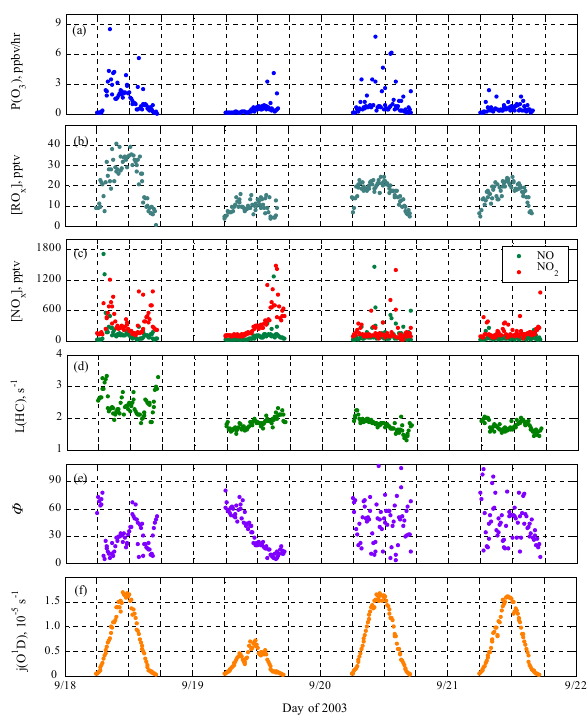
Fig. 2. Time series of (a) ozone production rate ( P (O 3 )), (b) RO x , (c) NO x (NO and NO 2 ), (d) OH reactivity due to HC ( L (HC)), (e) Φ and (f) j (O 1 D) in 10-min averages during 18–21 September, 2003.